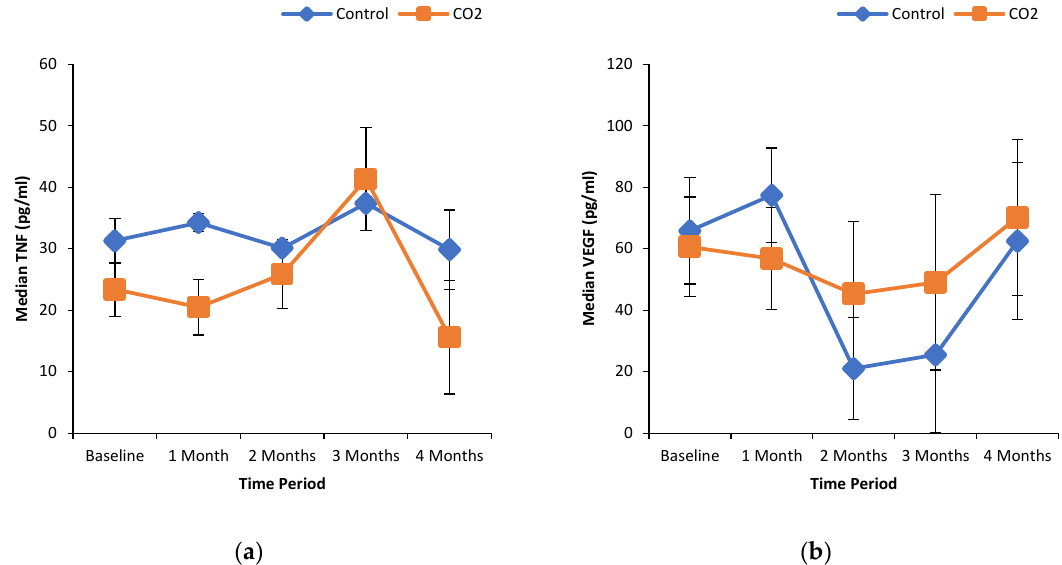
Figure 4. Effect of CO 2 -water bathing on markers of inflammation and angiogenesis in the serum of patients with foot ulcers. TNF- α ( a ) and VEGF ( b ) were measured by ELISA method as per manufacturers (Invitrogen) instructions and as described elsewhere [35]. Blood samples were collected before and at the end of every month of the treatment period (for a total of 5 collections) for the measurement of VEGF and TNFα. Table 3. Baseline characteristics, fasting blood glucose, HbA1c, lipid profile and wound/limb characteristics of patients enrolled into the study.